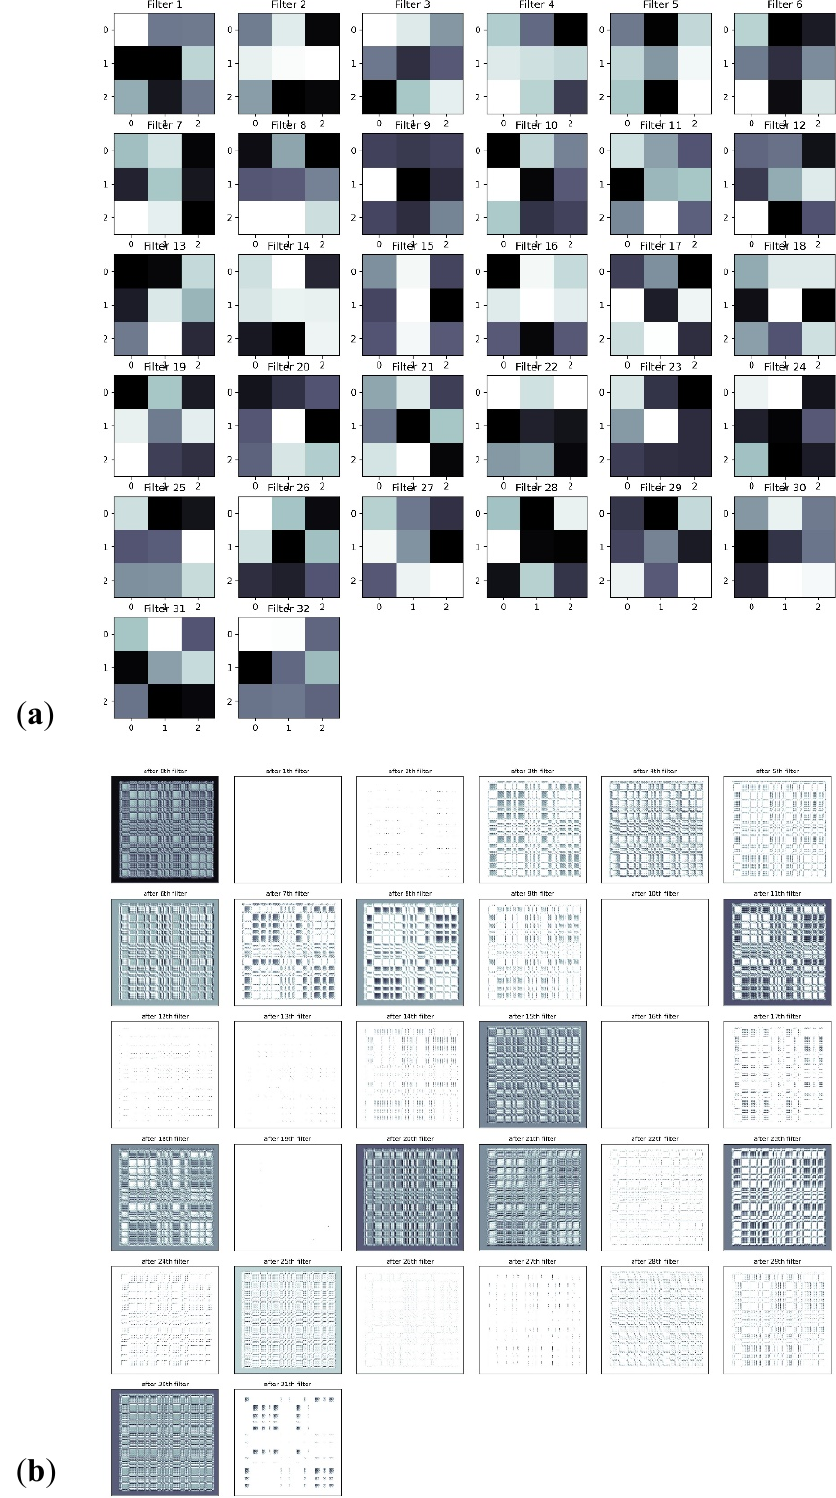
Figure 7. The feature extraction for the first convolution layer, ( a ) filter map for the first convolution layer, ( b ) feature map.